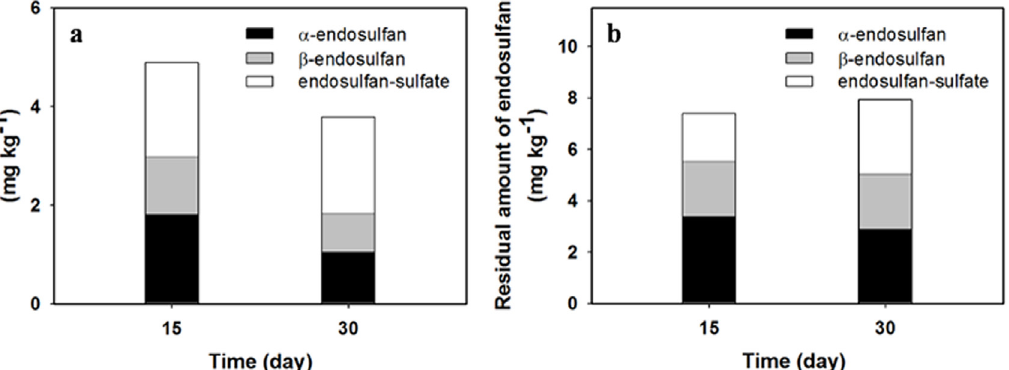
Fig 1. Uptake patterns of isomers and sulfate-metabolite of ED from soils in cucumber grown under two treatment concentrations: (a) 20 mg kg -1 and (b) 40 mg kg -1 in an indoor